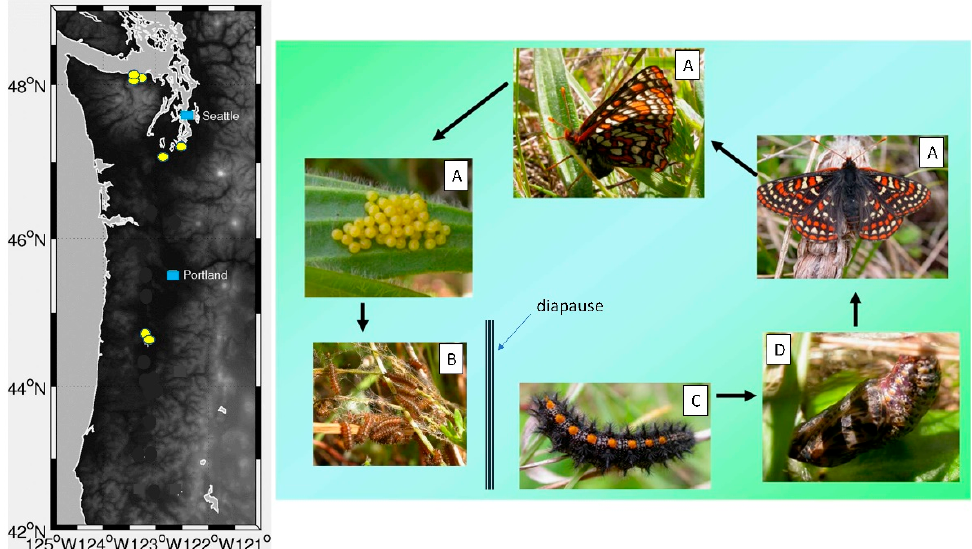
Figure 1. Left: Map of extant Taylor’s checkerspot populations (yellow circles) in Washington and Oregon, USA. Major cities Seattle, Washington and Portland, Oregon are represented by blue squares. Right: Life cycle of Taylor’s checkerspot butterfly and general development timing. Life stages ( A ) appearance of reproductive adult butterflies and oviposition on the pre-diapause larval foodplant (April-May). ( B ) Pre-diapause larvae feed on leaves within webbed shelters spun on the oviposition plant (May-June) and enter diapause in July. ( C ) Post-diapause larvae resume feeding activity in the winter (January-March) and ( D ) pupation occurs in March-April.